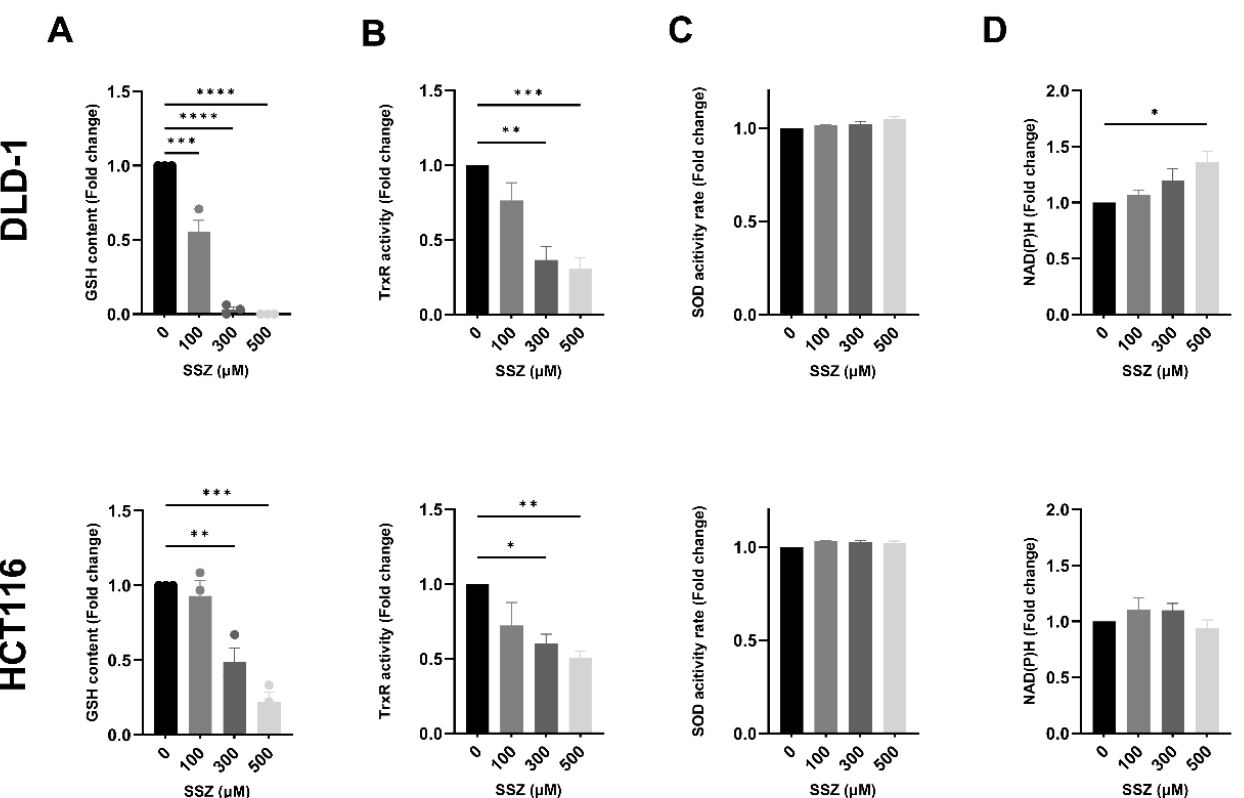
Figure 3. xCT inhibition severely affects different aspects of redox homeostasis under hypoxic condi- tions. DLD-1 and HCT116 were treated with SSZ (16 h) under hypoxic conditions (1%), and levels of different antioxidants were determined and normalized to their respective controls. ( A ) Summa- rizing graph showing the levels of GSH in DLD-1 (top) and HCT116 (bottom) cell lines. ( B ) TrxR activity in DLD-1 (top) and HCT116 (bottom) cell lines. ( C ) SOD activity levels were determined in DLD-1 (top) and HCT116 (bottom) cell lines. ( D ) NAD(P)H levels were evaluated in DLD-1 (top) and HCT116 (bottom) cell lines. Data are shown as mean ± SEM, n = 3. A one-way ANOVA was per- formed, followed by Dunnett’s multiple comparison test for statistical analyses. * p < 0.05, ** p < 0.01, *** p < 0.001, **** p < 0.0001.